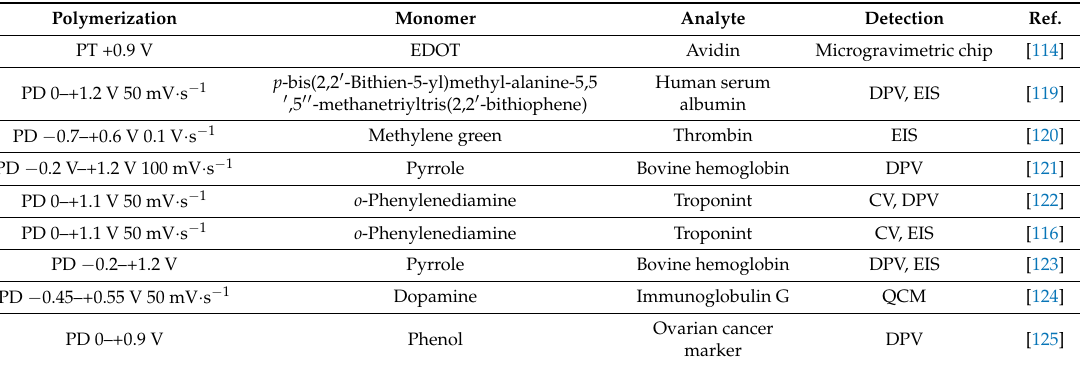
Table 1. MIPs for protein